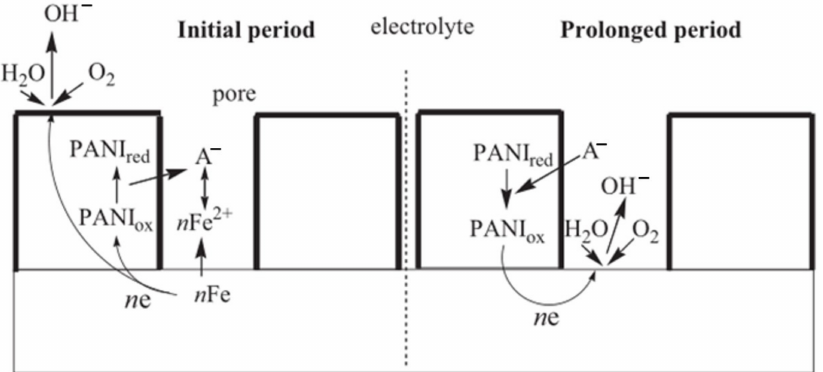
Figure 12. Proposed mechanism of the mild steel corrosion protection with PANI coatings